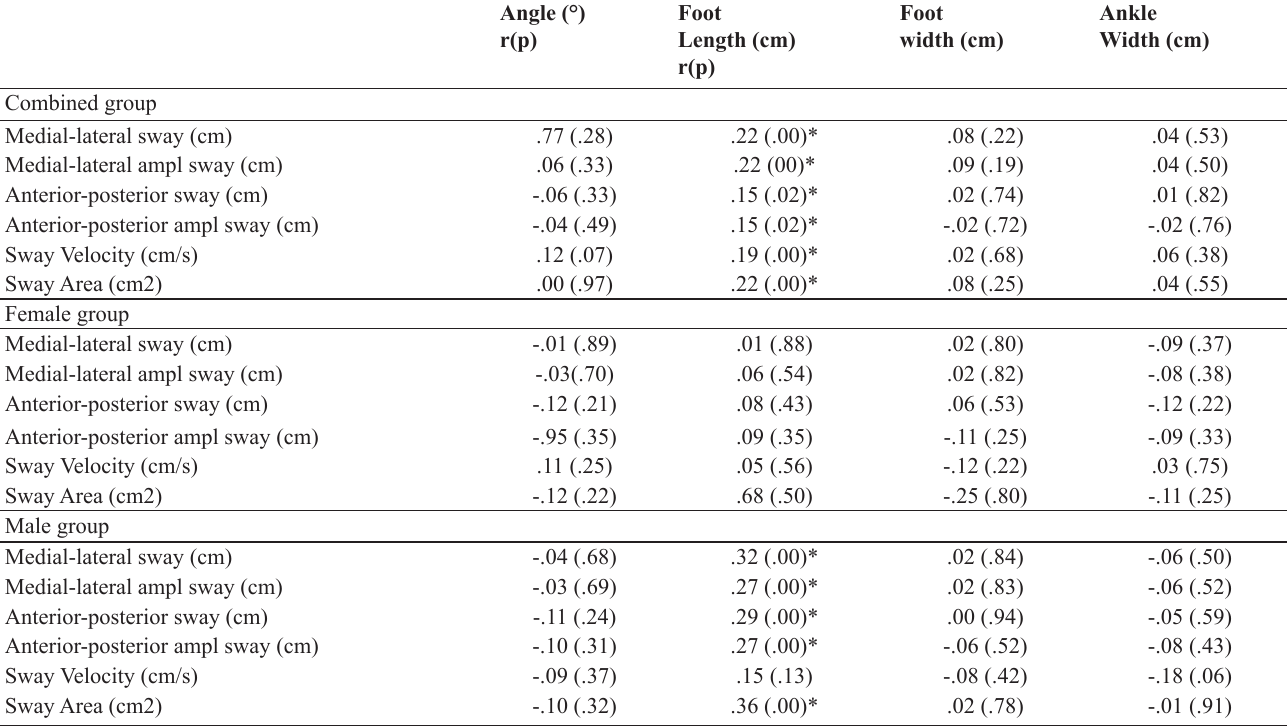
Table 4. Correlation between the anthropometric measurements of the foot and balance, N=200